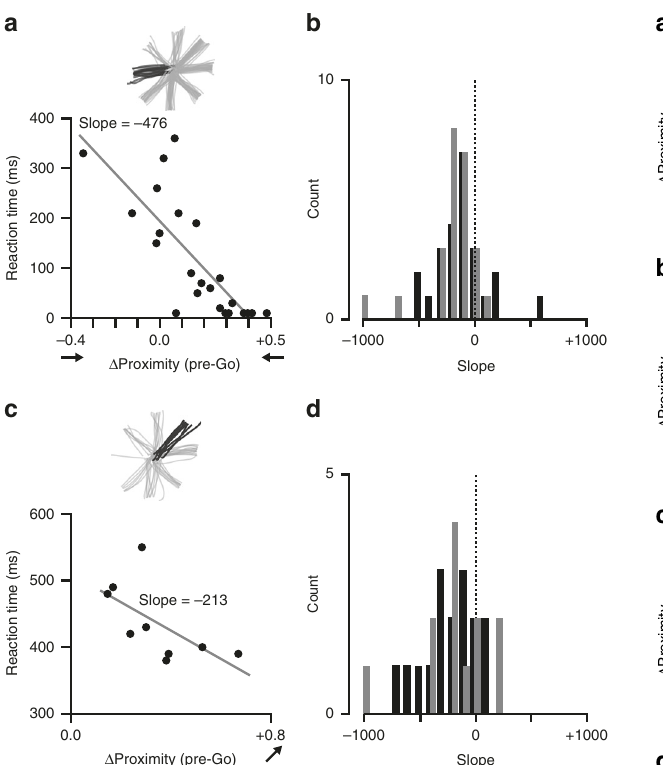
Fig. 9 Correlation between pre-Go neural state and reaction time.